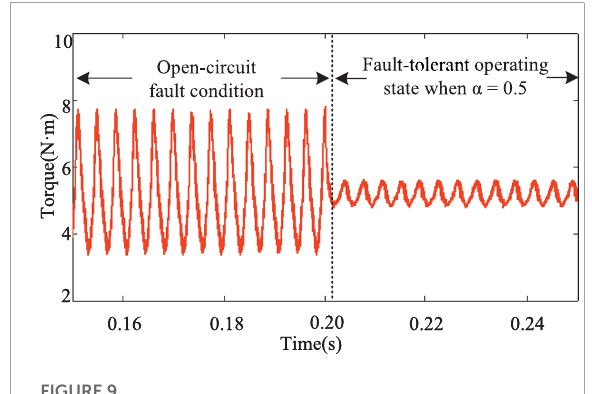
FIGURE 9 Torque under the condition of motor fault and FT when α = 0 . 5.